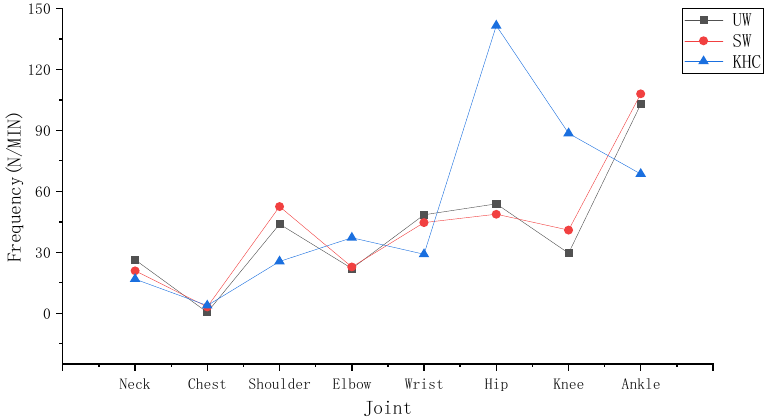
Figure 7. The joint frequency. UW—upright walking; SW—stoop walking; KHC—knee and hand crawling.